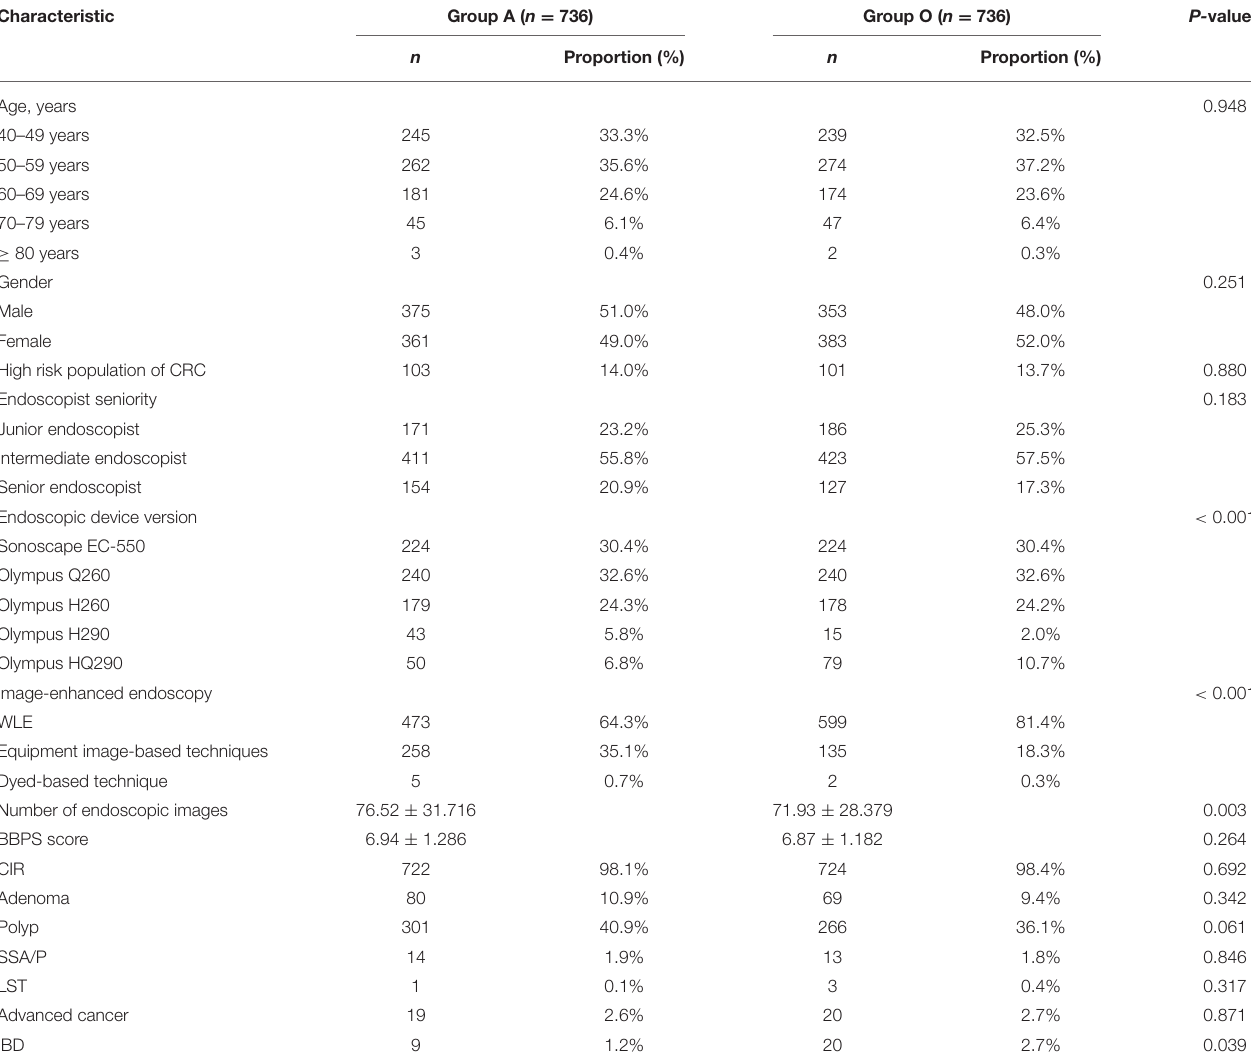
TABLE 2 | Patient characteristics of the propensity-matched cohort.